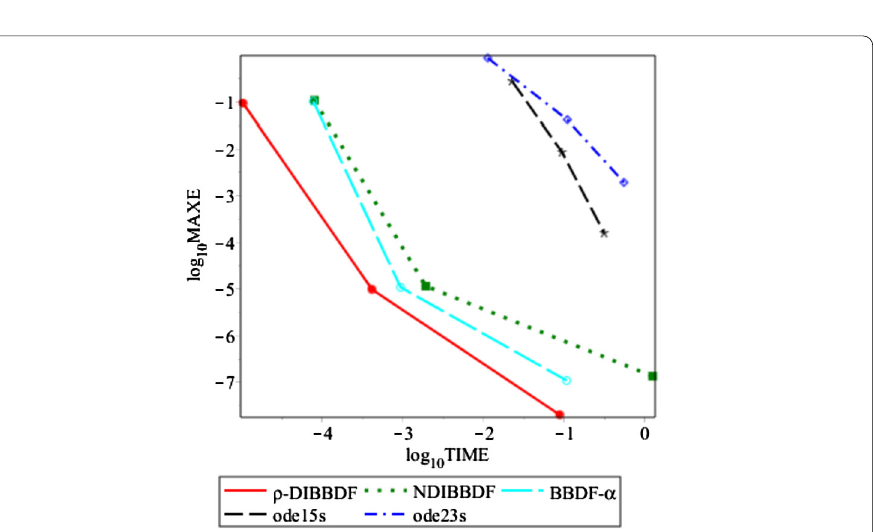
Figure 12 Graph for log 10 MAXE against log 10 TIME of Model C(iii)